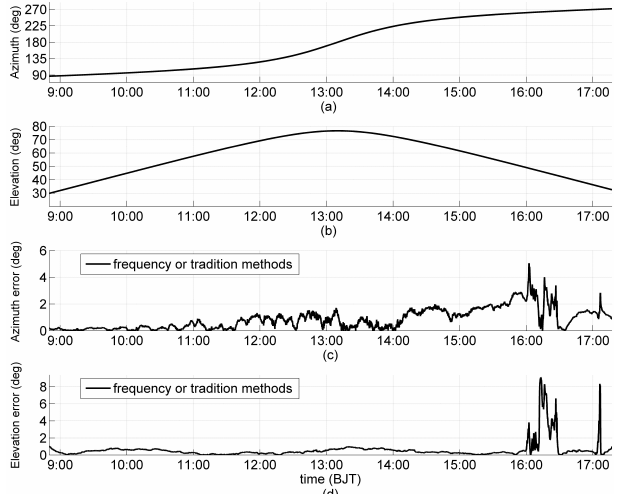
Figure 7. Solar azimuth angle ( a ); elevation angle ( b ); solar experimental orientation error for Array 7 ( M = 16 ) comparing the method of frequency analysis to the traditional method, including the errors of the solar azimuth angle ( c ); and the elevation angle ( d ). Data points are at every 10 seconds. Cloud impacts are shown from 1545–1630 and at around 1707 BJT.